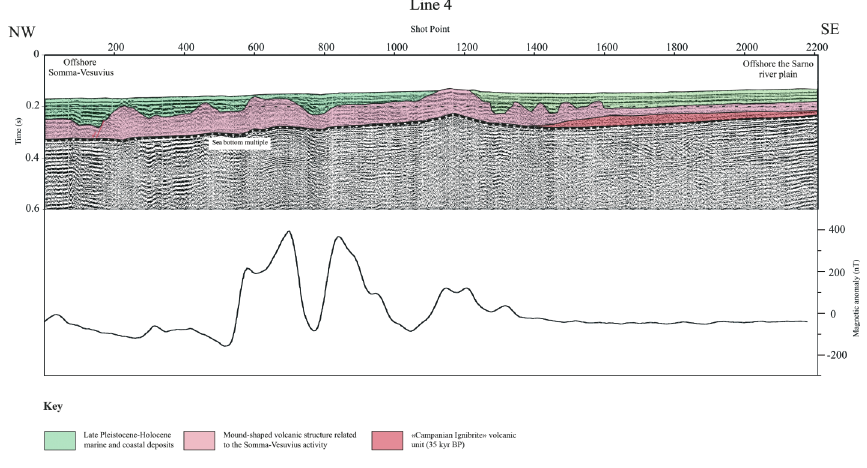
Fig. 4. Seismic profile GR09 and corresponding interpretation. The relative magnetic profile is reported in the inset. Note the occurrence of an important magnetic anomaly (in the order of 500 nT) in a wide volcanic struc- ture located offshore of the Torre del Greco town and related to the Somma-Vesuvius volcanic